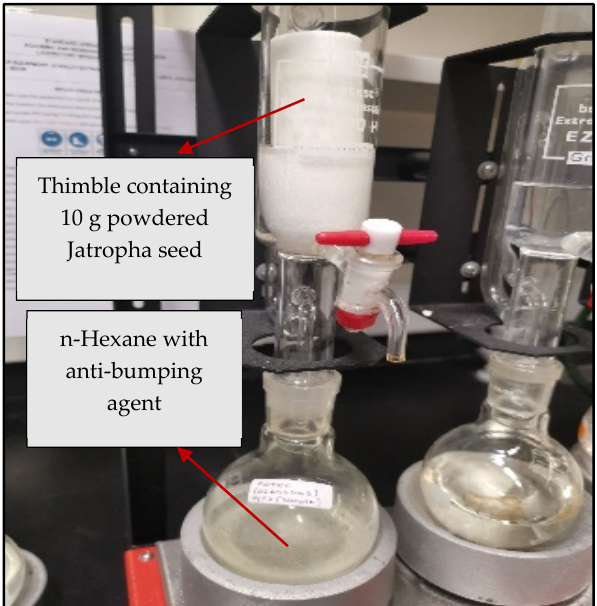
Figure 3. Soxhlet extractor design.